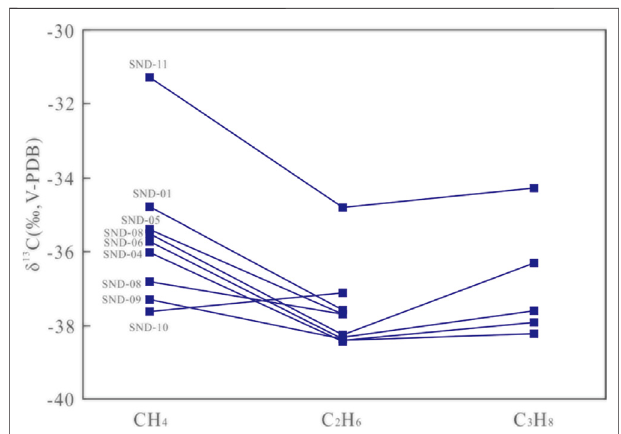
FIGURE 2 | Distribution characteristics of the carbon isotopic composition of the Niutitang Formation shale gas in the study area. See Figure 1 for sample